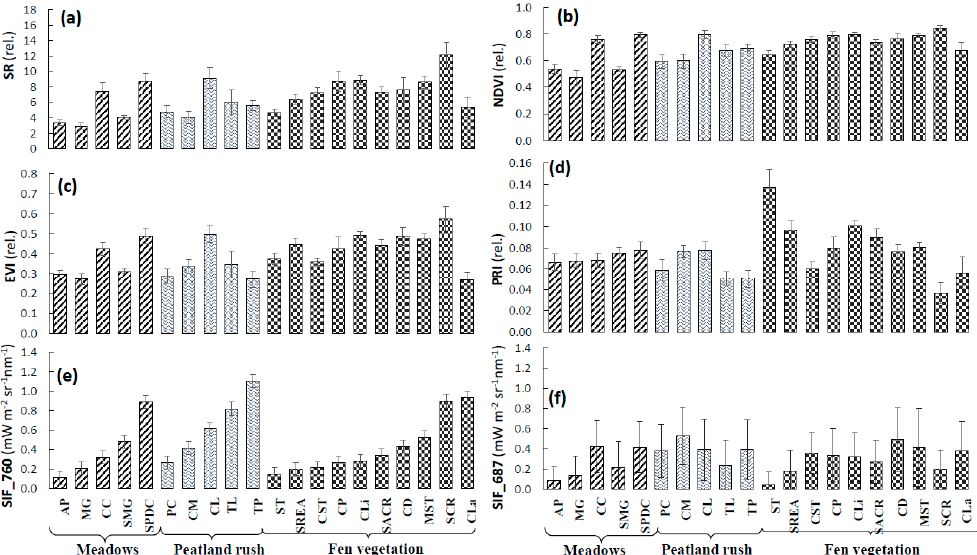
Figure 9. Bar diagram presenting the average values of the observed vegetation indices and SIF derived from HyPlant data; ( a ) SR, ( b ) NDVI, ( c ) EVI, ( d ) PRI, ( e ) SIF 760 , and ( f ) SIF 687 . The codes corresponding to the names of the individual plant communities are written at the bottom of the bars and correspond to the abbreviations provided with Figure 3b. Detailed description of these plant communities is provided in Table S1 (Supplementary Material). The first group of bars represents meadows (ME), the second group of bars represents peatland rush (PR) vegetation communities, and the third group of bars stands for the fen (FE) vegetation communities. Error bars represent standard deviation.